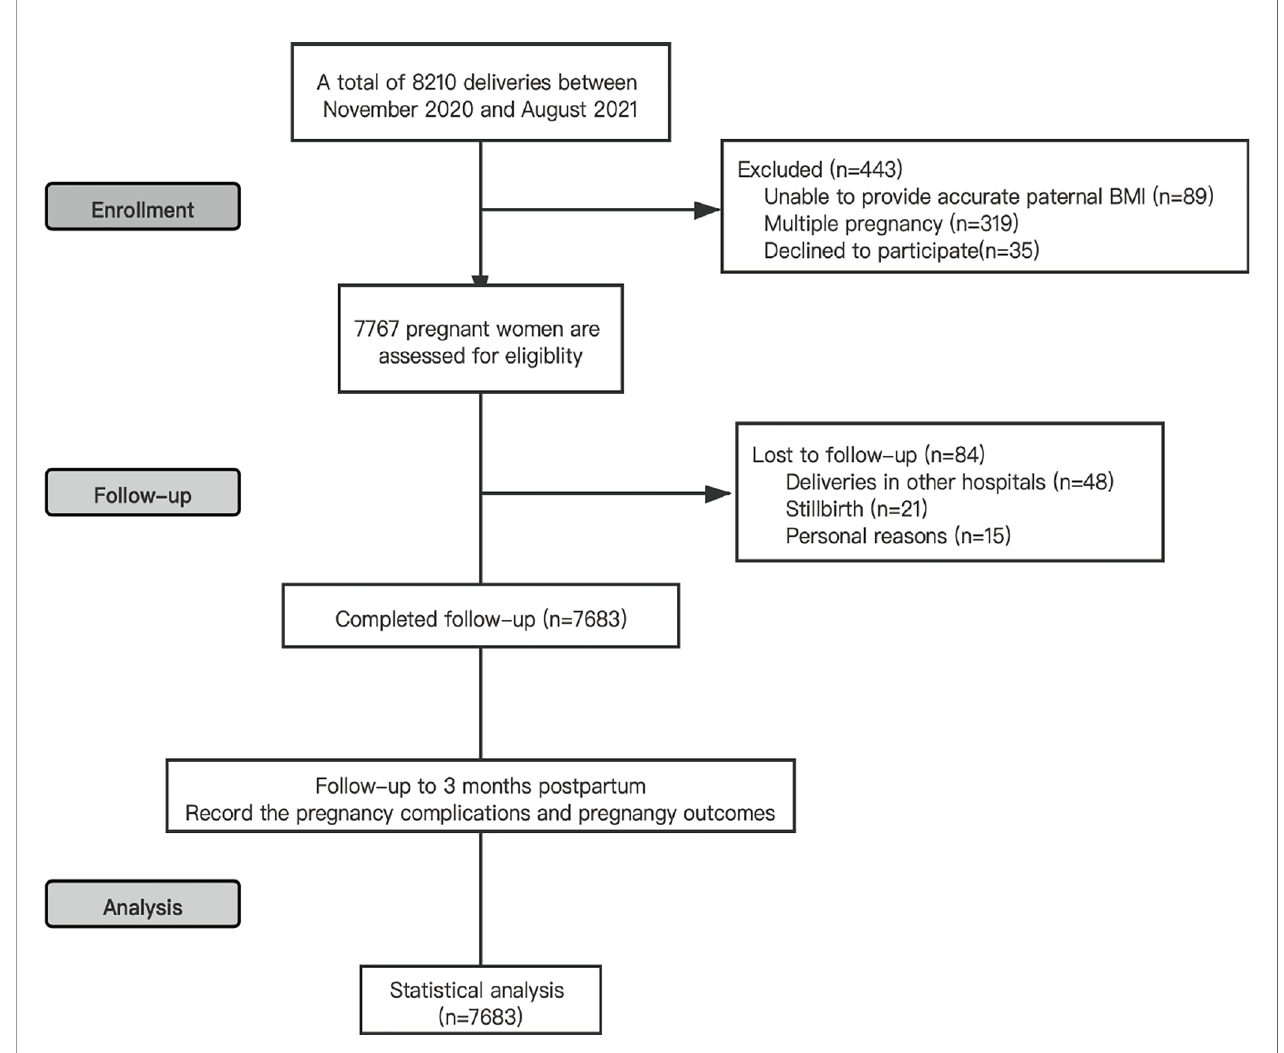
FIGURE 1 | Flowchart of participants in the